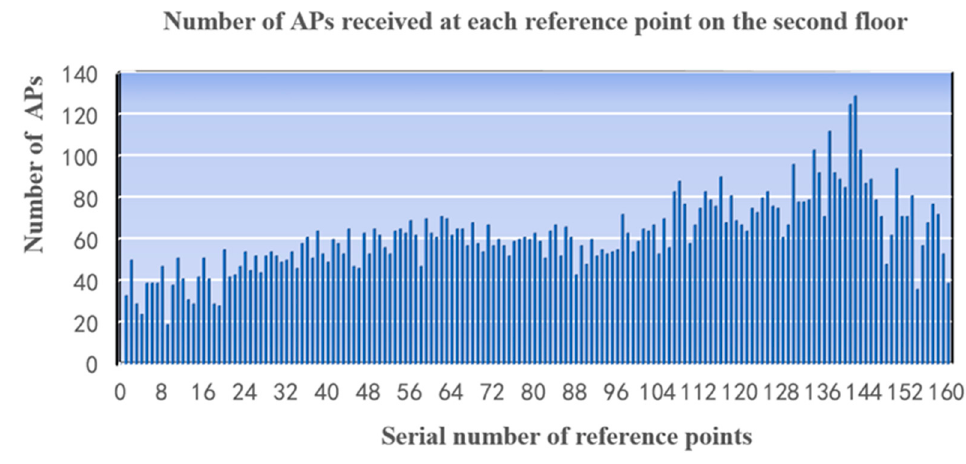
Figure 4. The number of APs received at each reference point on the second floor.